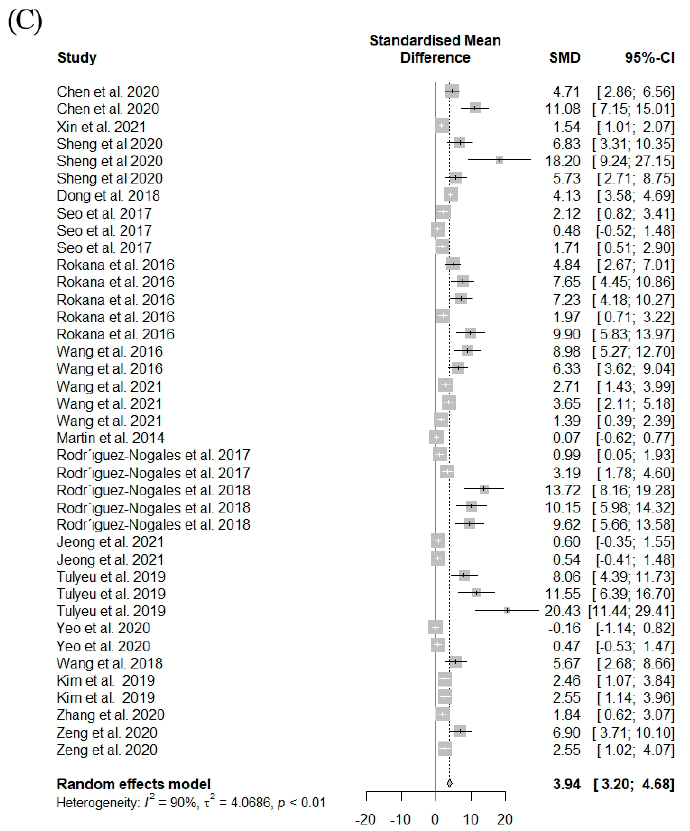
Figure 3. Forest plot for the effect size of probiotics administration on the mRNA expression of the tight junction protein by the random effects model. ( A ) claudin, ( B ) occludin, ( C ) ZO − 1. [23,29,33–